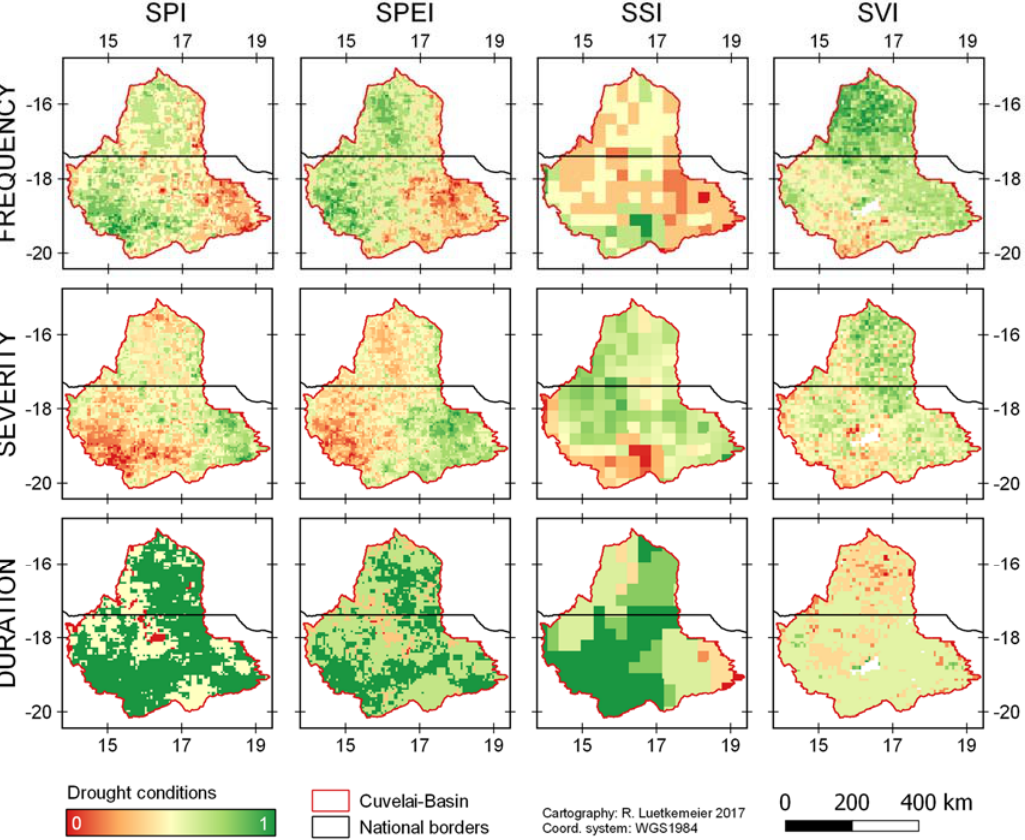
Figure 4. Drought indicator dimensions of frequency of occurrence, severity and duration, for the Cuvelai-Basin. The results are represented spatially on a normalized scale from 0 (unfavorable) to 1 (favorable). White pixels within the Basin are the result of “no-data” pixels from the initial NDVI vegetation dataset.